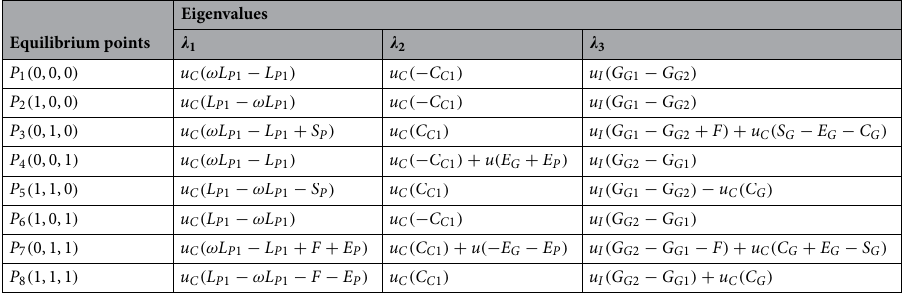
Table 3. Equilibrium points and eigenvalues of tripartite evolutionary game model.